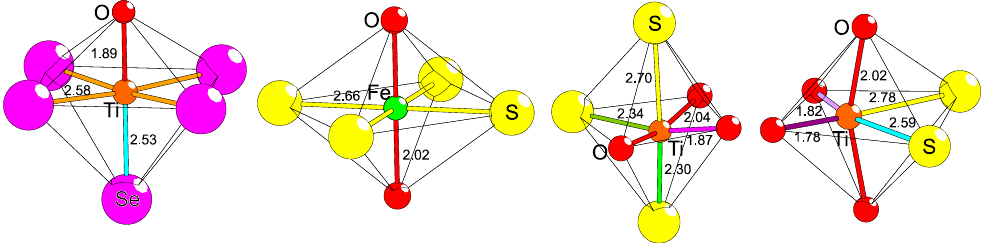
Figure 5. Different heteroleptic octahedral bichalcogenide coordinations of transition metals. From left to right: [TiSe 4/2 Se 1/1 O 1/1 ] 4 ´ in La 4 Ti 2 Se 5 O 4 [49], trans -[FeS 4/4 O 2/4 ] ´ in La 2 Fe 2 Se 2 O 3 [12], mer -[TiS 3/1 O 3/2 ] 5 ´ in La 6 Ti 2 S 8 O 5 [51], and cis -[TiS 1/1 S 1/2 O 2/1 O 2/2 ] 5 ´ in Pr 6 Ti 2 S 7 O 6 [50] are shown. Interatomic bonds with the same color have the same bond lengths (in Å).